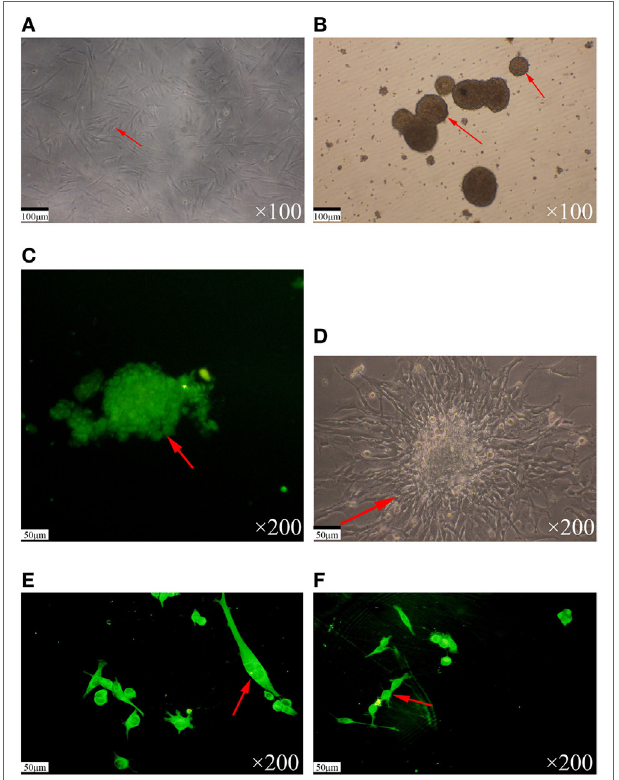
FigUre 2 | The morphology of TJ905 cells and stem cells under optical and fluorescence microscopy. (a,B) The TJ905 cells appeared normal under optical microscopy. (c,D) The TJ905 cells were luminous under fluorescence microscopy. (e,F) The TJ905 stem cells in suspended growth state under optical microscopy. (g,h) The TJ905 stem cells were luminous under fluorescence microscopy.